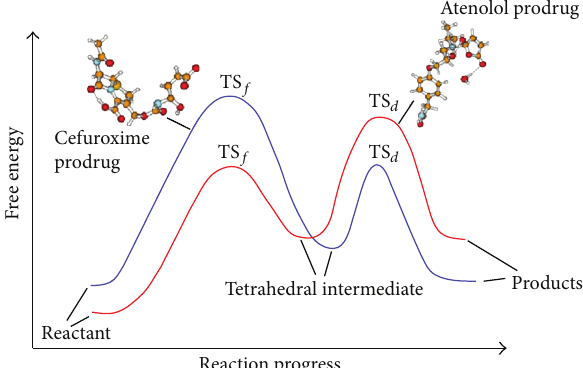
Figure 8: Energy profiles for the acid-catalyzed hydrolysis of atenolol and cefuroxime